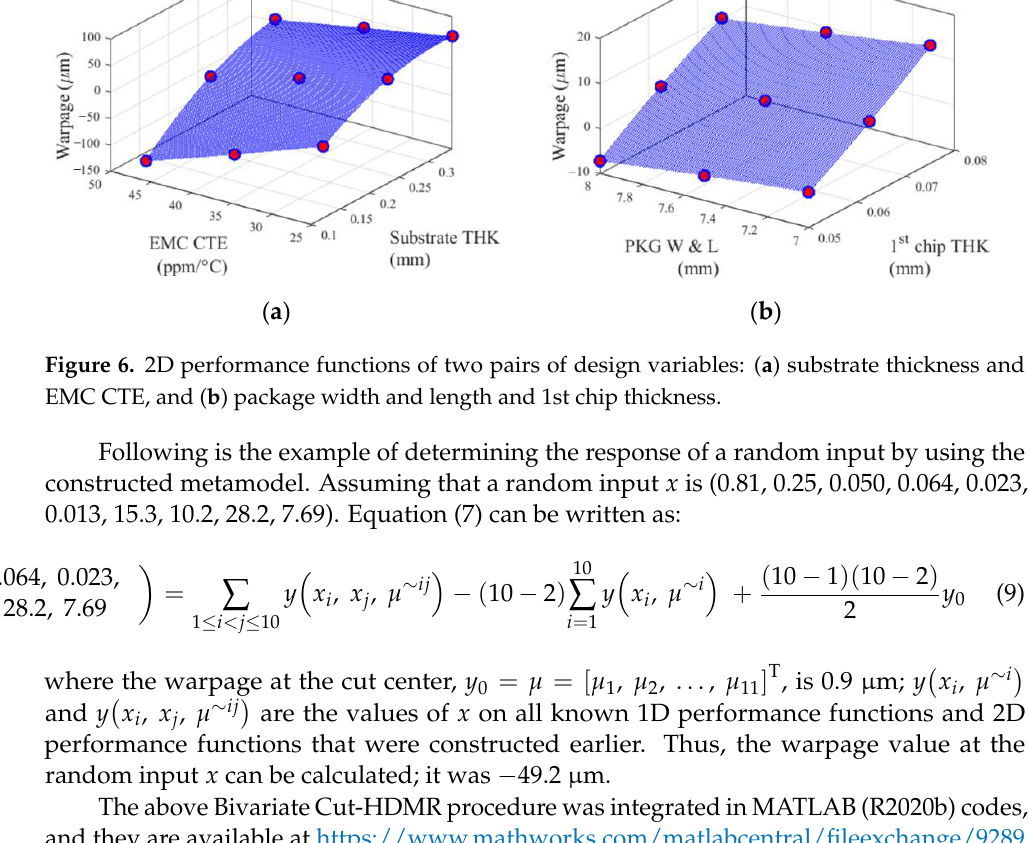
Figure 5. 1D performance functions of two design variables: ( a ) EMC thickness and ( b ) sub- strate thickness.